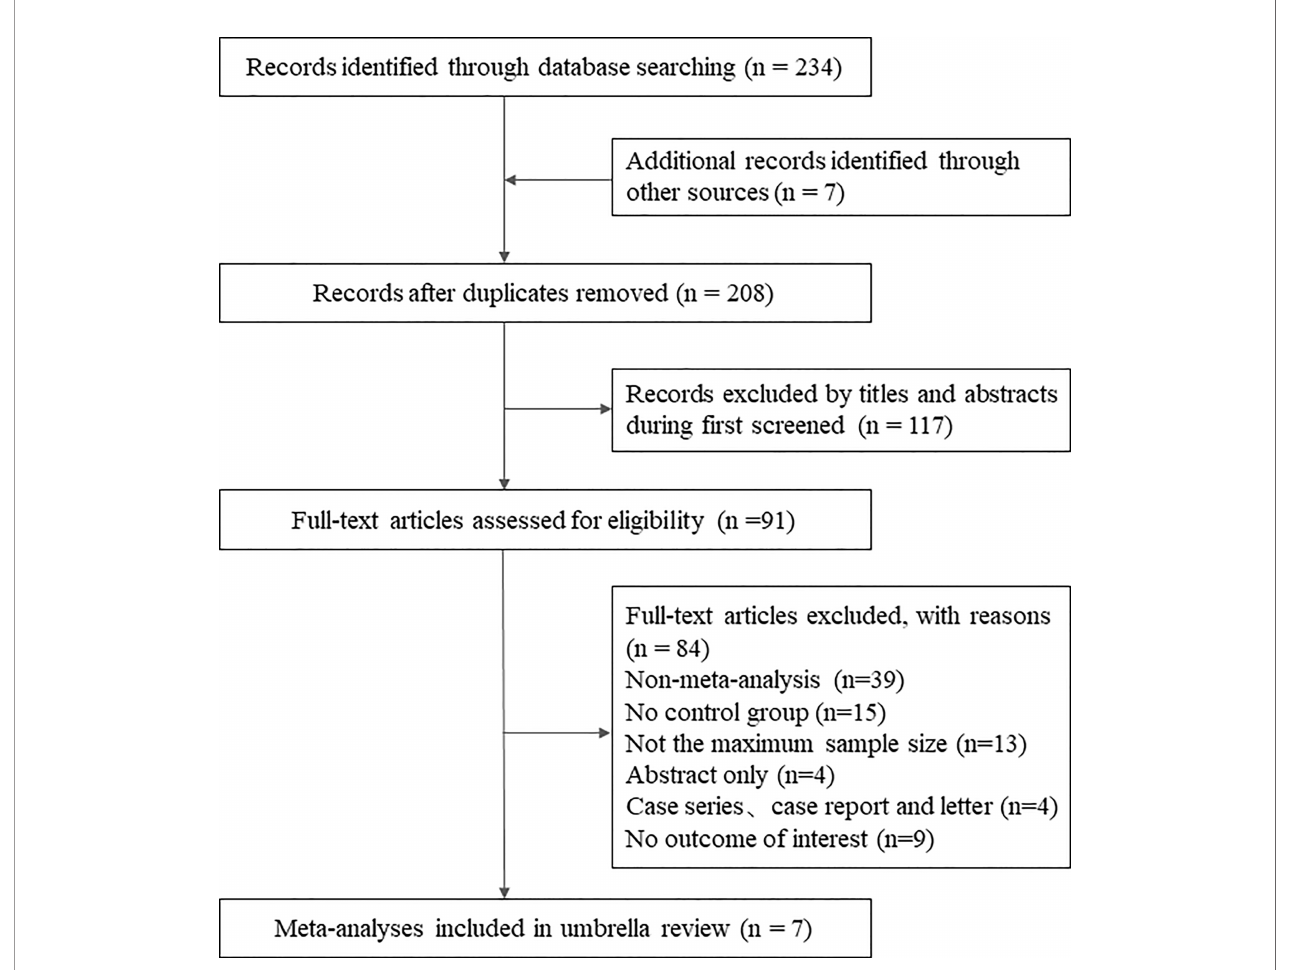
FIGURE 2 | The fl owchart of the literature